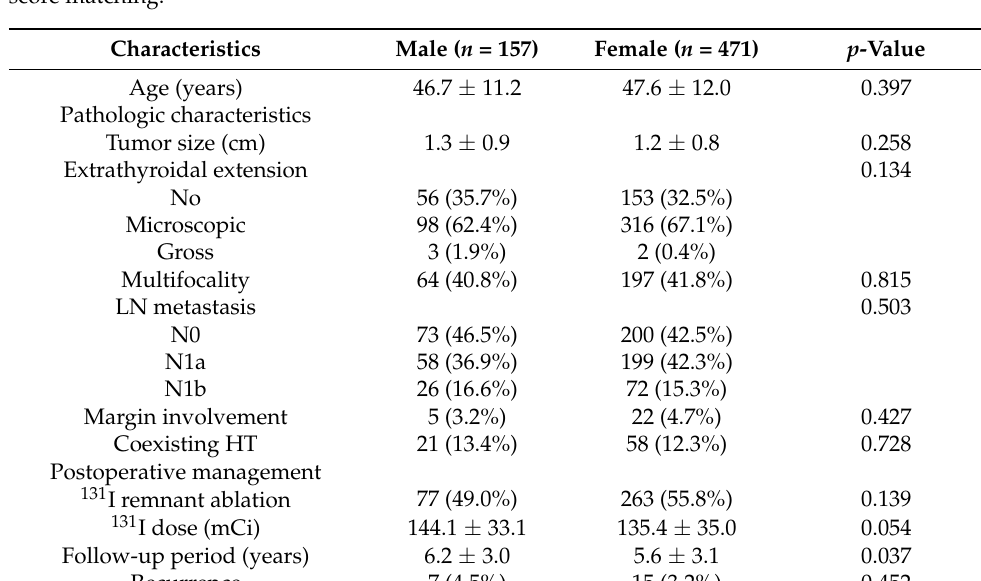
Table 2. Comparison of clinicopathological characteristics according to sex after 1:3 propensity